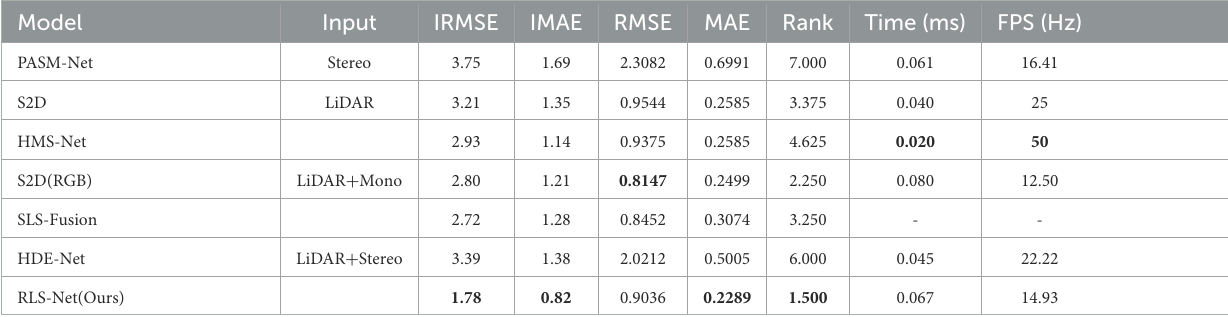
TABLE 1 Comparison of real-time network effect on KITTI.